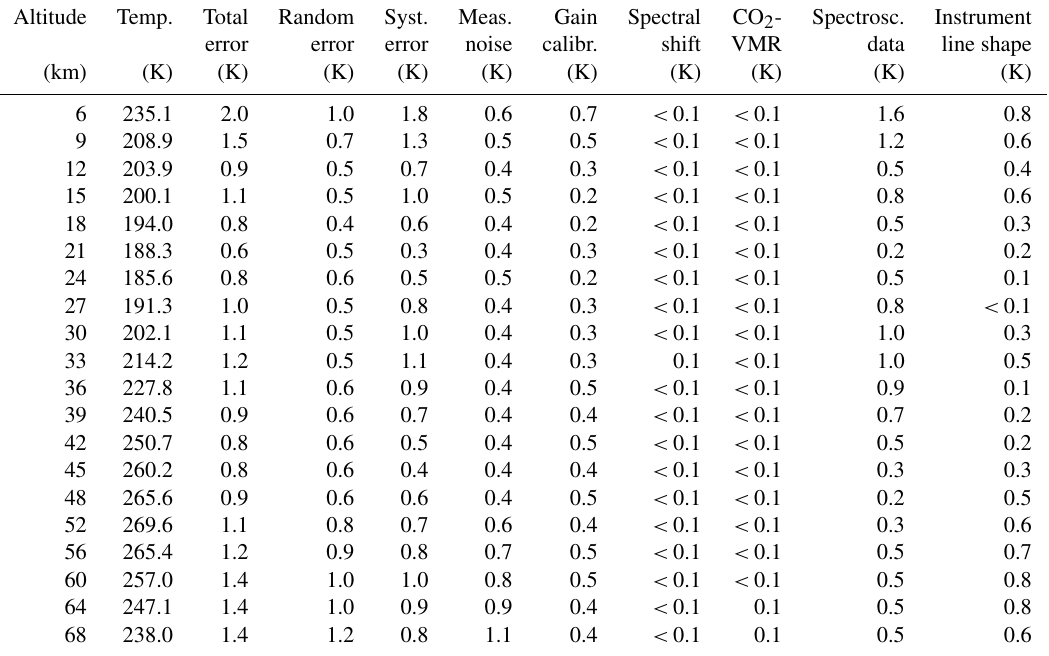
Table A2. RR data temperature error budget for southern polar winter night. All uncertainties are 1 σ . Altitude